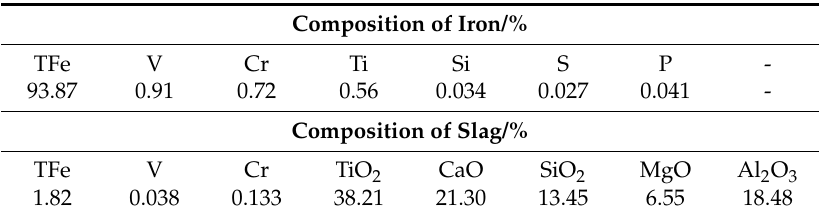
Table 6. Main chemical compositions of separated iron and slag (wt %). Composition of